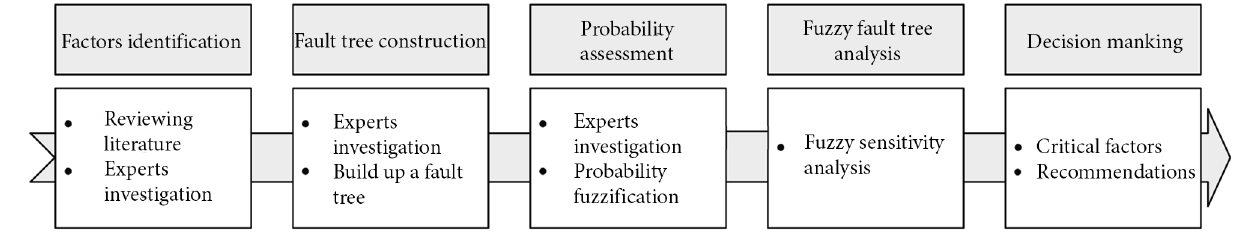
Table 1. Summary of previous research in different countries on factors influencing CLP